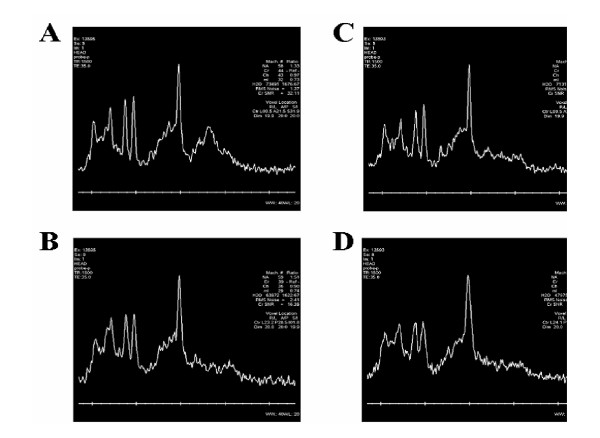
Representative spectra from two selected participants (#1 and #2) showing Voxels of Interest (VOIs) at unaffected Midline Prefrontal and affected Left Hippocampal regions. A) Representative spectrum from the non-affected midline prefrontal VOI of Participant #1. B) Representative spectrum from the left posterior hippocampus VOI of Participant #1 showing an increase in NAA/(tCr+Cho) after prolonged rote learning. C) Representative spectrum from the non-affected midline prefrontal VOI of Participant #2. D) Representative spectrum from the left posterior hippocampus VOI of Participant #2 showing a significant increase in NAA/(tCr+Cho) after prolonged rote learning.